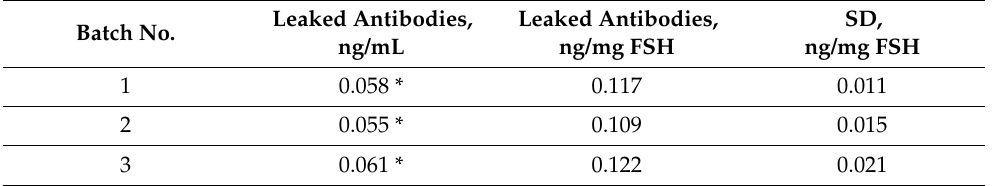
Table 2. Leaked antibodies content in the recombinant human follicle-stimulating hormone (r-hFSH) drug substance. * value below the quantification limit (LOQ = 0.080 ng/mL). Batch